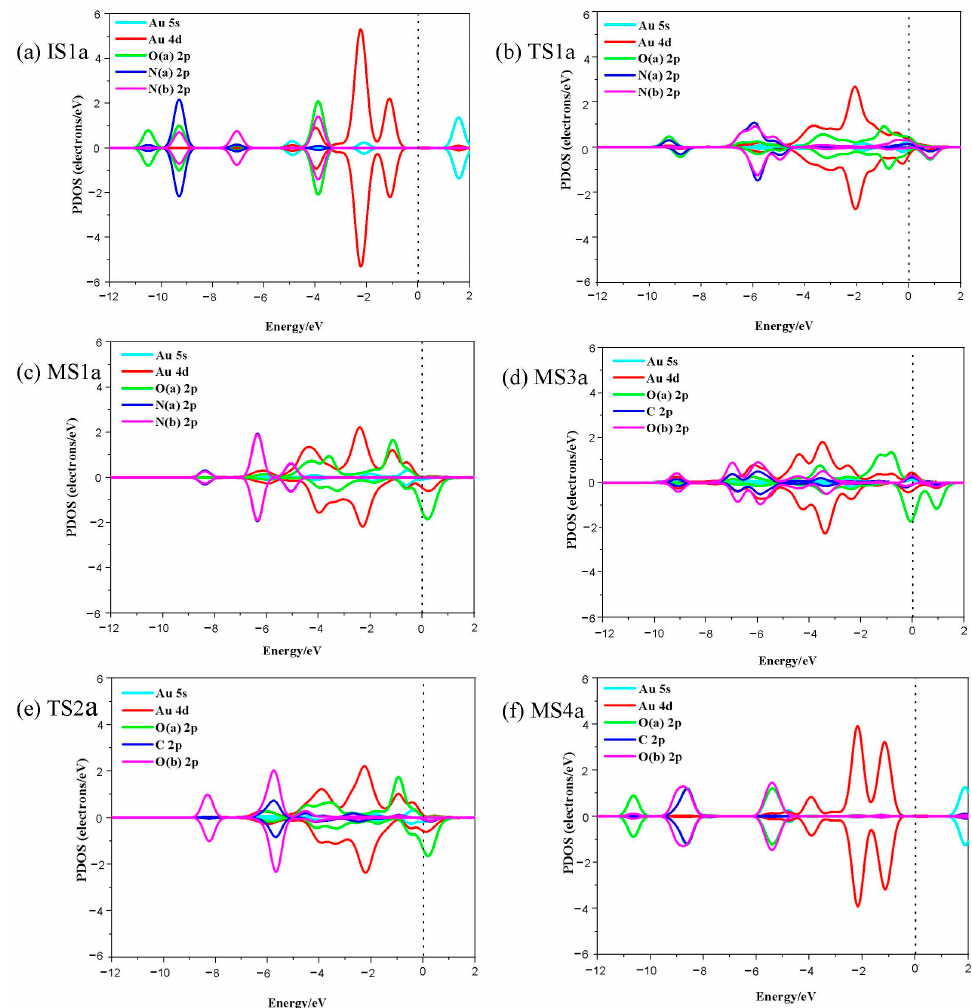
Figure 5. The PDOS of relevant species in N 2 O reduction mechanism I on Au/C 2 N. (N(a) represents the N atom bonding with O atoms, and N(b) represents the ending N atom in N 2 O. O(a) and O(b) are from N 2 O and CO, respectively). ( a ) IS1a, ( b ) TS1a, ( c ) MS1a, ( d ) MS3a, ( e ) TS2a, ( f ) MS4a